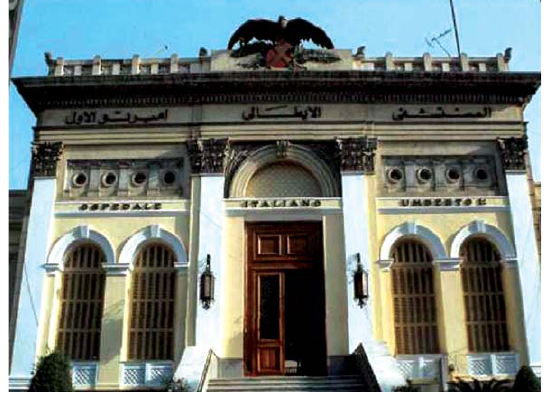
Fig. 1. Italian hospital in Cairo.